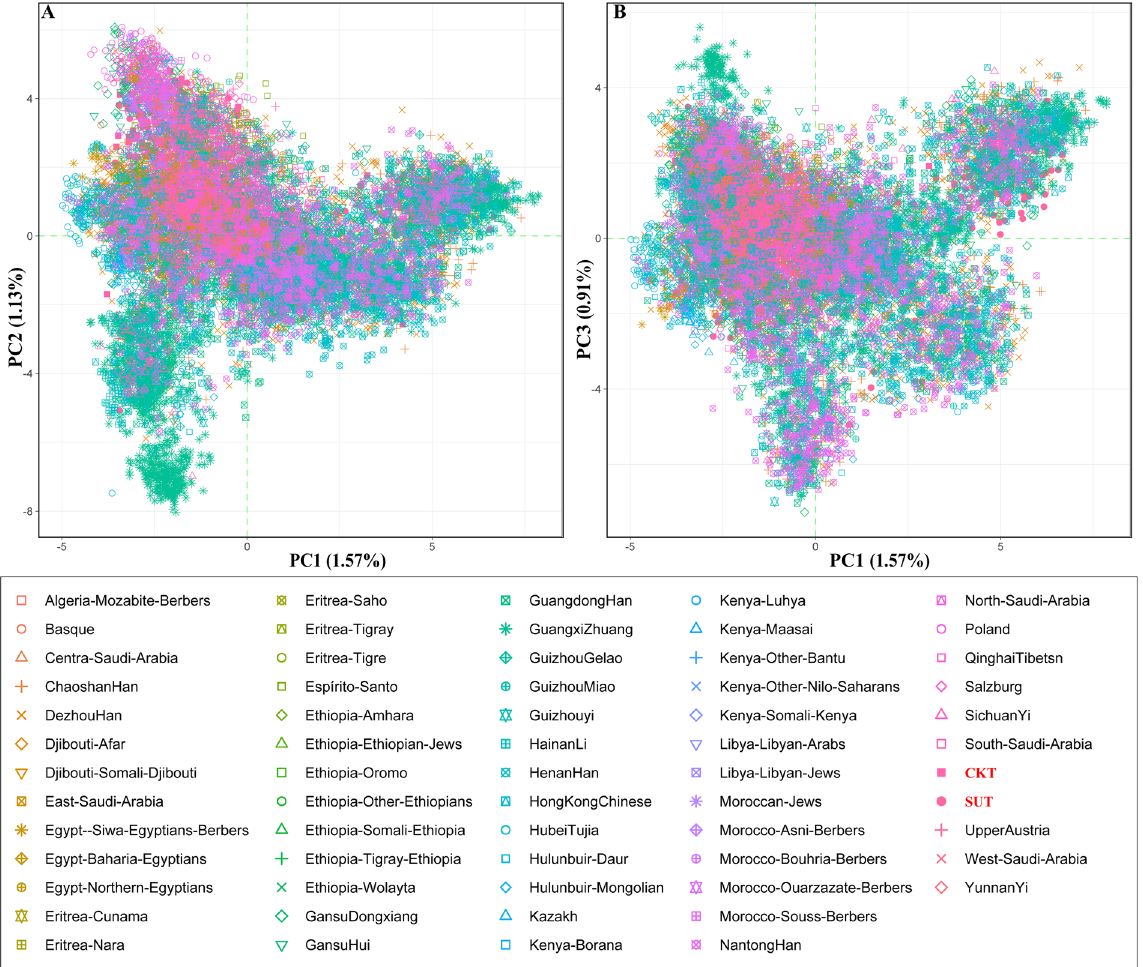
Figure 2. Principal component analysis among 63 worldwide